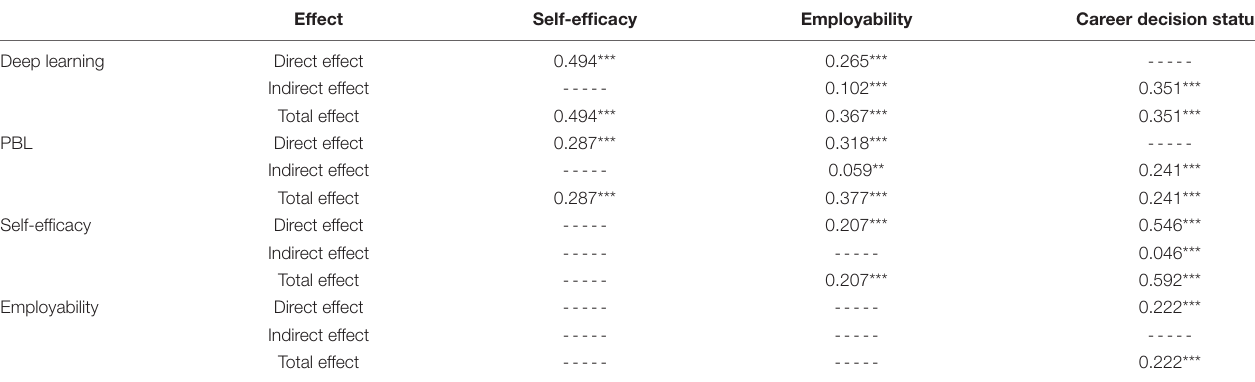
TABLE 3 | Path coefficient of direct, indirect and total